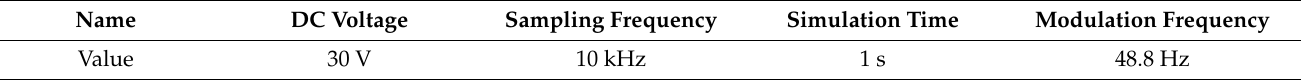
Table 9. Simulation conditions.